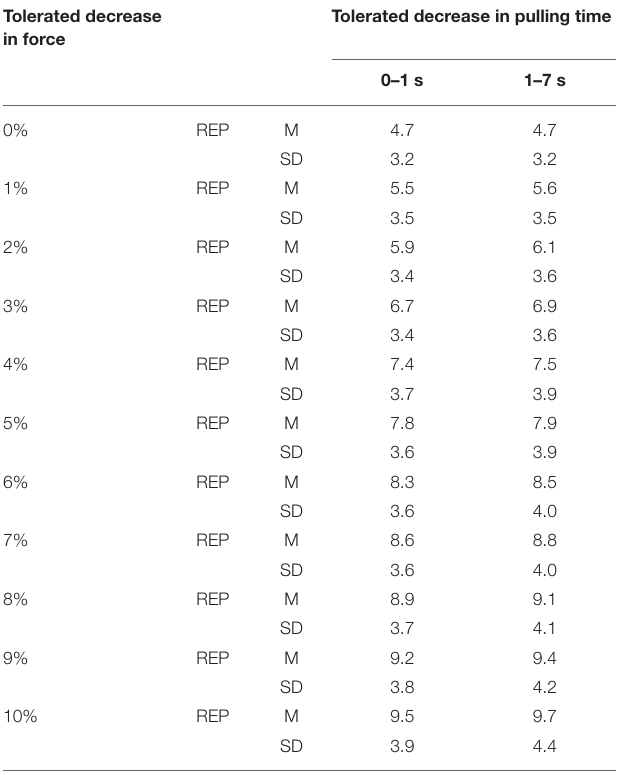
Tolerated decrease in pulling